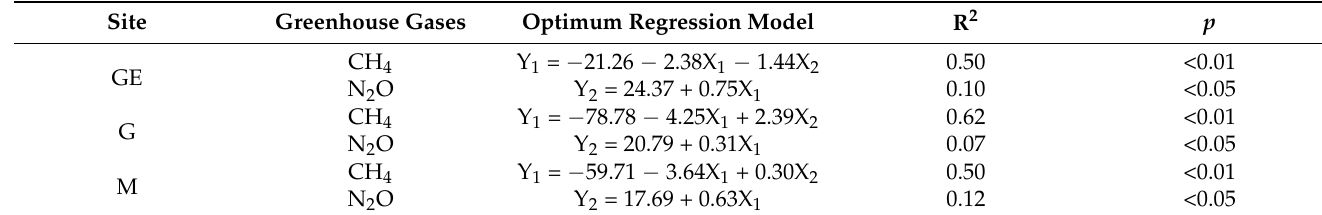
Table 2. Stepwise regression analysis of CH 4 and N 2 O fluxes with soil temperature and soil water content in the three land-use types during the entire experiment period. Sites: grazing-exclusion (GE); grazing (G); mowing (M). Y 1 : CH 4 ; Y 2 : N 2 O; X 1 : soil temperature; X 2 : soil water